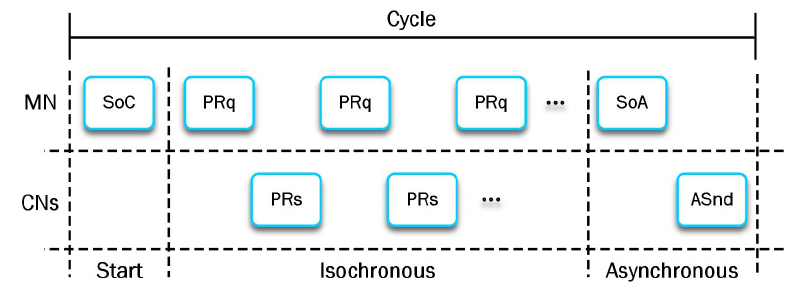
Figure 1. Timing diagram of an EPL communication